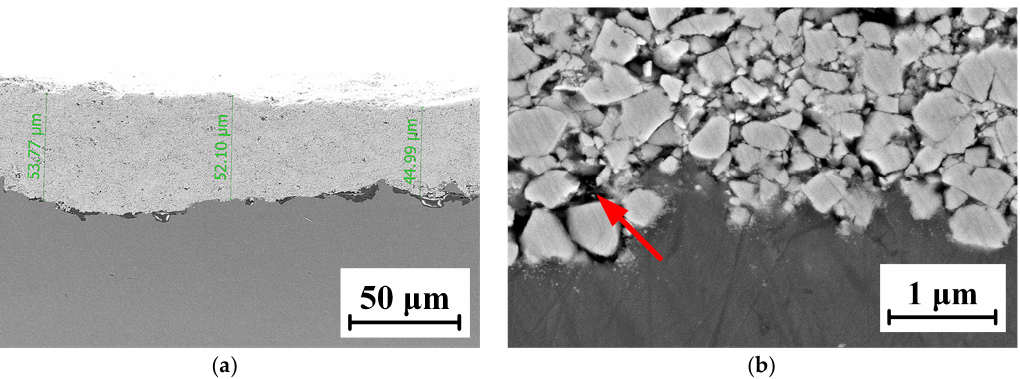
Figure 11. The SEM micro-morphology of the WC-12Co coating. ( a ) Cross-sectional morphology of the coating at 0.5 K times magnification; ( b ) Cross-sectional morphology of the coating at 20 K times magnification times